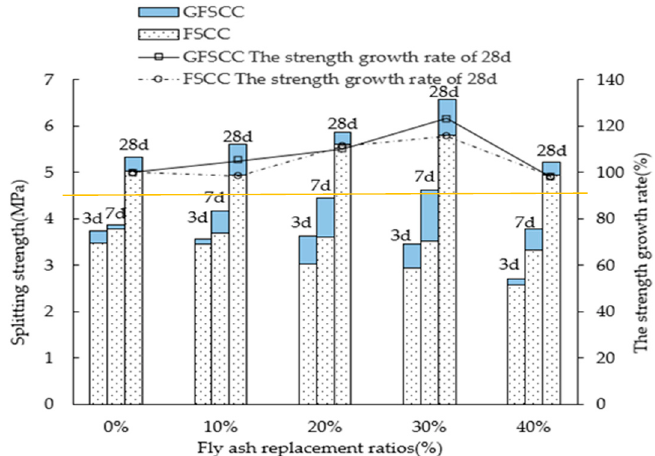
Figure 8. The strength and growth rate.